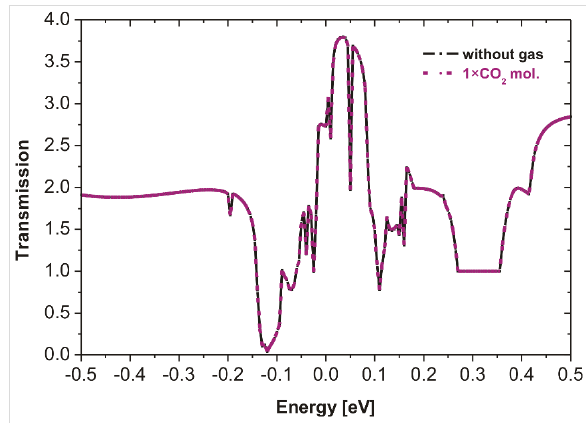
Figure 6: Transmission spectra of hybrid ZnO NRs/NCD sensor struc- ture with and without one CO 2 molecule. Zero energy is the Fermi